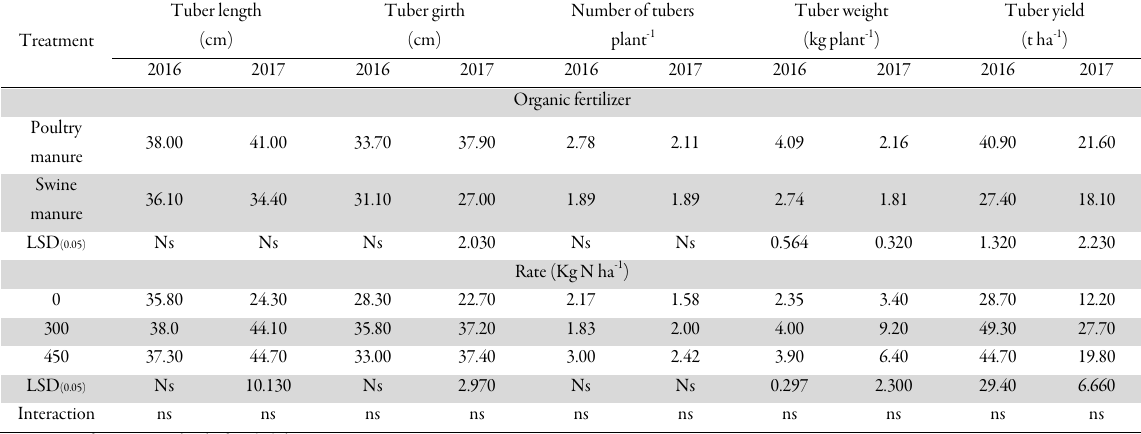
Table 3. Yield and its components of white Guinea yam as influenced by poultry and swine manures